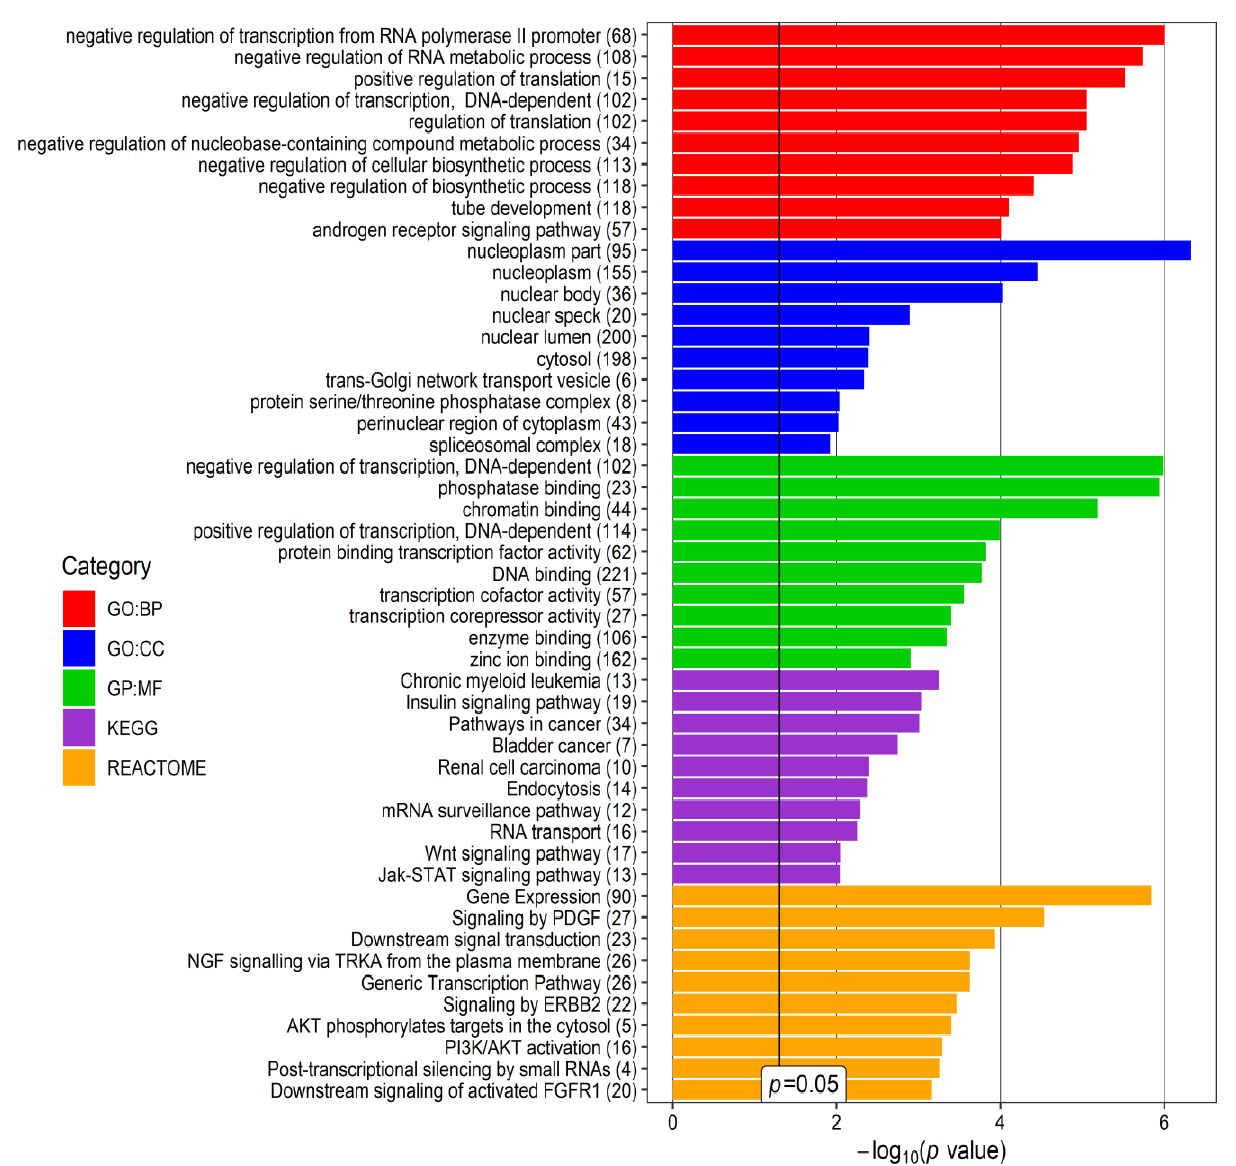
Figure 5. Top 10 terms of the Gene Ontology (GO): Biological Processing (GO:BP), GO: Cellular Compartment (GO:CC), Molecular Function (GO:MF), REACTOME and KEGG (Kyoto Encyclopedia of Genes and Genomes) categories, revealed for glaucoma- and/or pseudoexfoliation syndrome (PEX)-associated genes targeted by downregulated miRNAs found in the current study in the aqueous humor (AH) of patients with PEXG and age-matched controls. p -value—EASE score for enrichment adjusted by the Benjamini correction for multiple-hypothesis testing. The number in brackets following the names of terms indicates the number of associated genes. The plot was generated using the ggplot2 3.3.0 package in the R